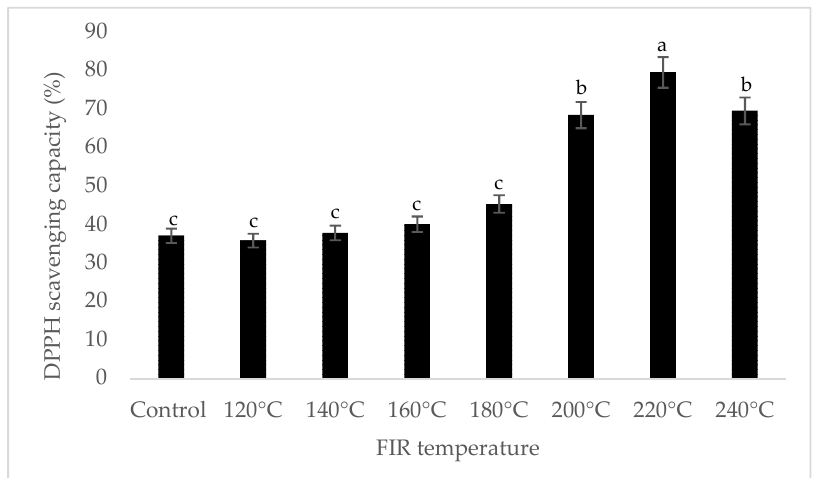
Figure 2. DPPH free radical scavenging activity of A. gigas Nakai treated by FIR irradiation. Each value is expressed as the mean ±SD ( n = 3). Different lowercase letters within the row indicate significant differences ( p <0.05) according to ANOVA. FIR: far infrared irradiation.